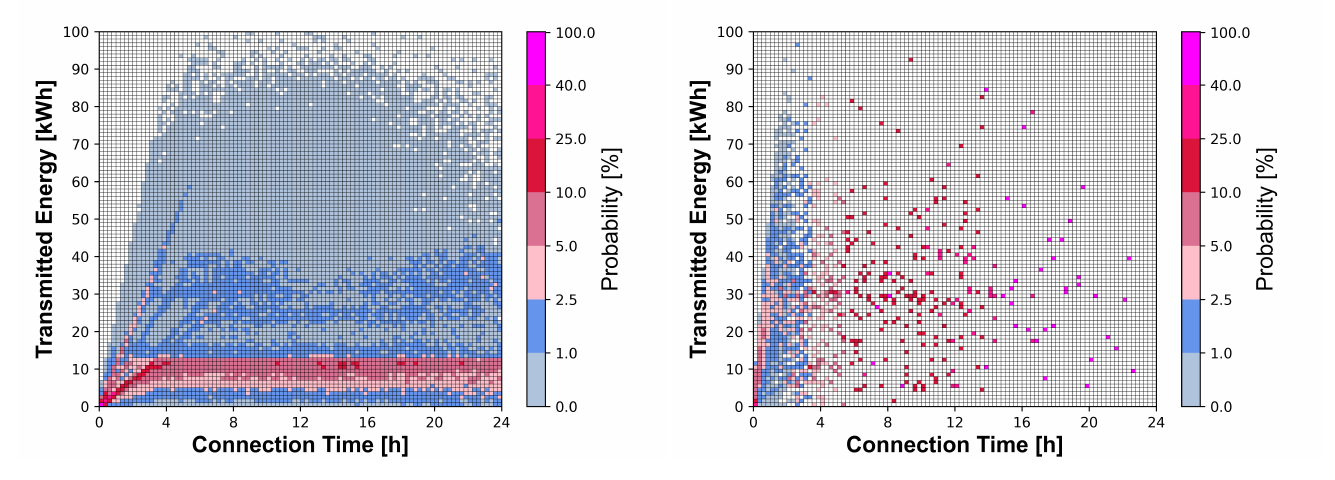
Figure 7. Conditional Probability Distribution of Transmitted Energy Given the Connection